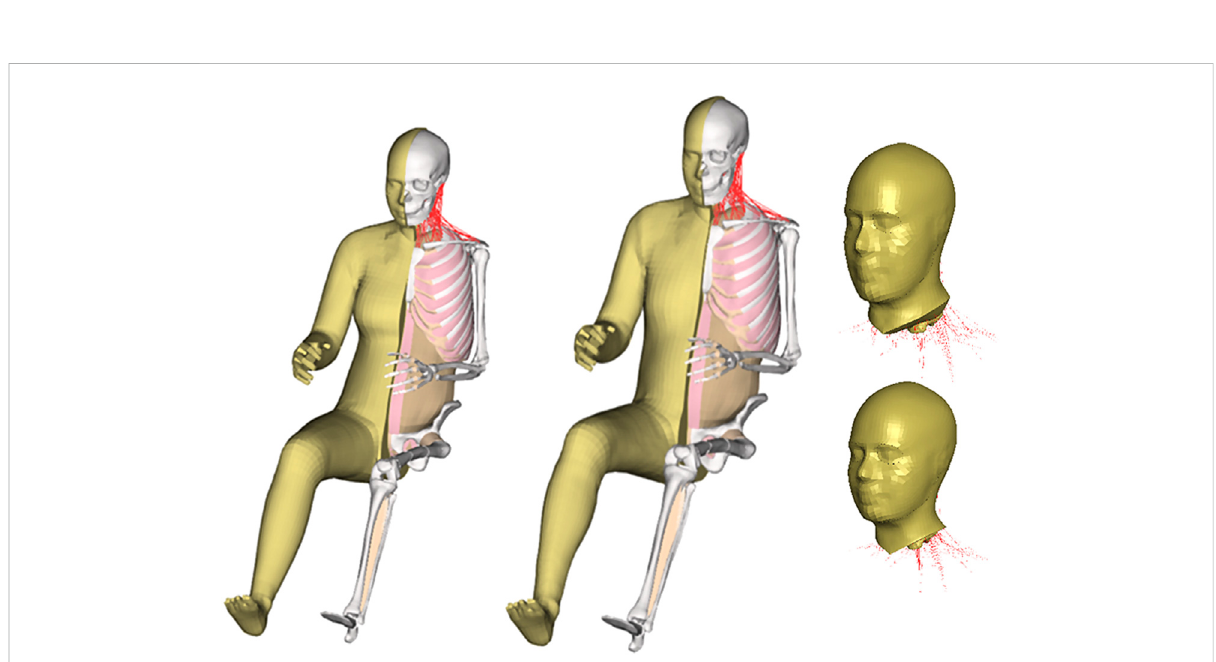
FIGURE 2 VIVA+ fi nite element human body models and isolated VIVA+ head-neck